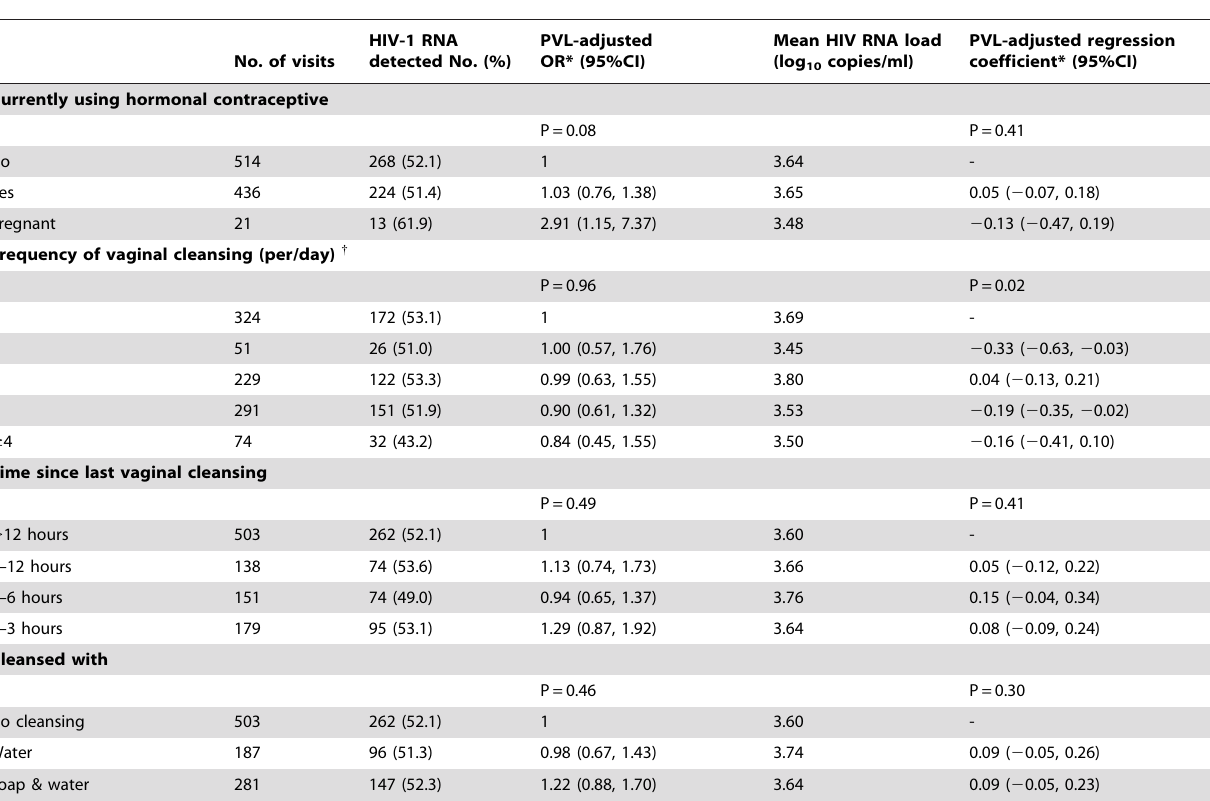
Table 1. Behavioural characteristics and association with cervico-vaginal HIV-1 RNA detection (in 482 women at 971 visits) and HIV-1 RNA